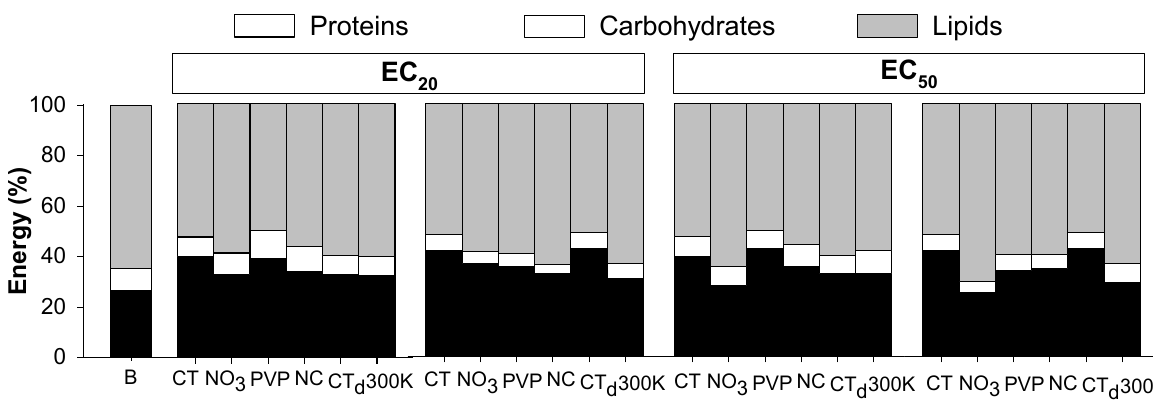
Figure 3. Proportion of energy reserves available (proteins, carbohydrates and lipids) in Enchytraeus crypticus after exposure to the concentrations of effect on reproduction EC 20 and EC 50 of silver nitrate (NO 3 ) and three silver nanoparticles: Ag PVP-Coated (PVP), Ag Non-Coated (NC) and Ag NM300K (300K) for 0, 3 and 7 days. CT: control, CTd: control dispersant, B: Baseline (organisms from